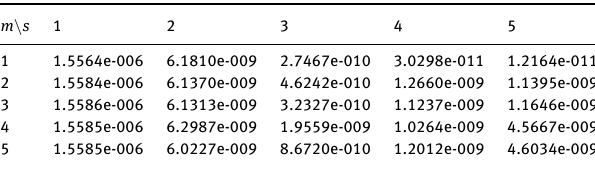
Table 12: Maximum errors E N for example 5 using N t = 5, N x = 10 and t = 16. m \ s